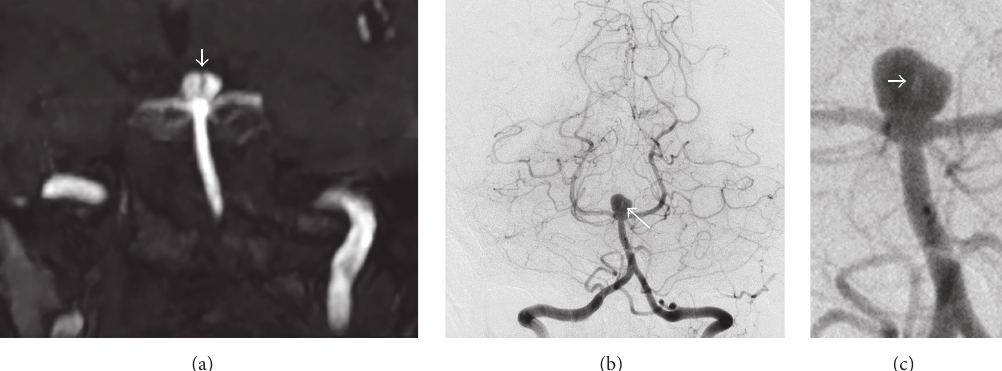
Figure 1: MRI demonstrating a saccular basilar tip aneurysm with a likely internal septum (a) which was confirmed on angiography (b) and its magnified view (c).